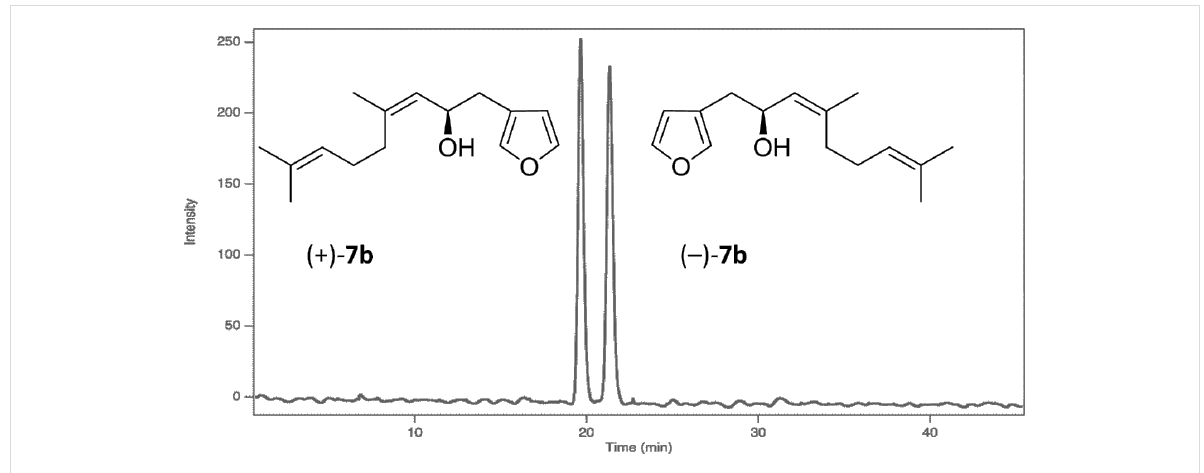
Figure 4: Analytical enantioselective HPLC trace showing separation of individual enantiomers of (6 Z )-5-hydroxydendrolasin (Chiralpak AD column, 250 × 4.6 mm, 2% IPA in n -hexane at 0.5 mL/min, UV detection at 214 nm).